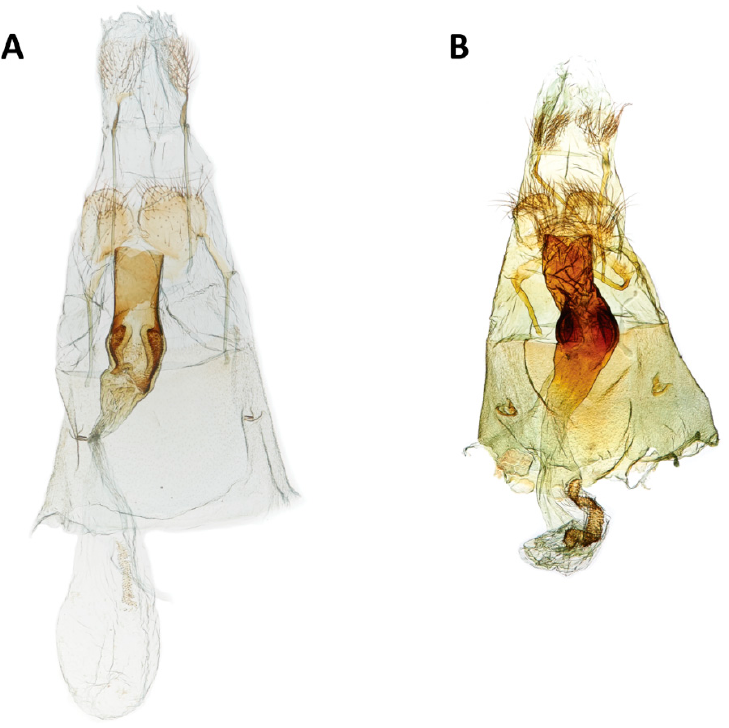
Figure 5. Female genitalia, ventral view. ( A ) Casmara subagronoma (USNMENT01328216, USNM slide # 146,477). ( B ) C. agronoma (USNMENT01200871, USNM slide # 146,473).